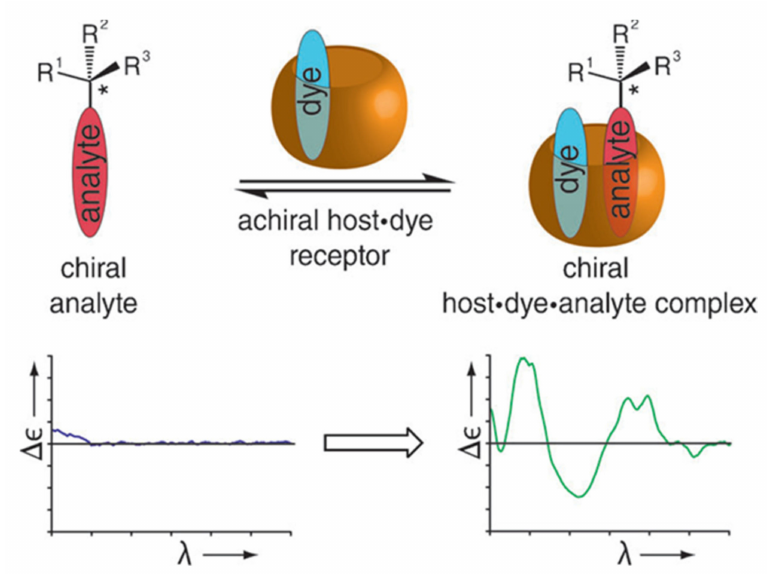
Figure 1. The binding process of chiral analyte with host · dye complex to form ternary complex. The weak CD signal in the far-UV region (280 nm) turns into a strong CD signal in the near-UV region (250–550 nm). Reprinted (adapted) with permission from Ref. [12] Copyright 2014 from